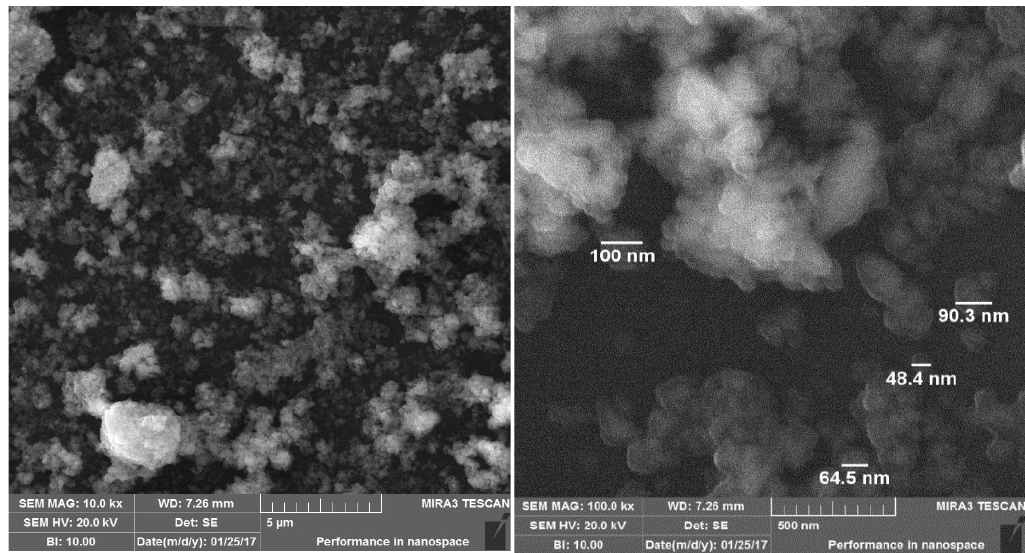
Figure 2 . SEM image of SnO 2 nanoparticles .